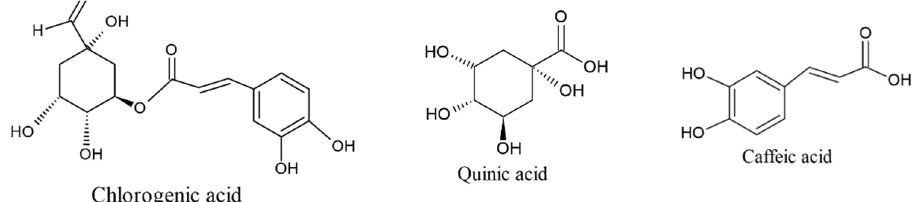
Figure 2. Structures of chlorogenic acid, quinic acid and caffeic acids identified in C. arabica.